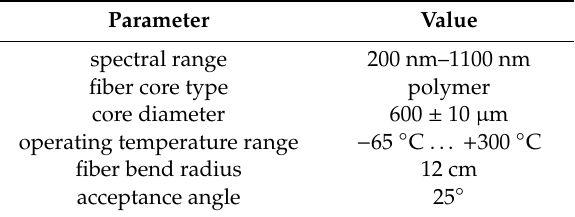
Table 1. Basic parameters of the optical fiber.